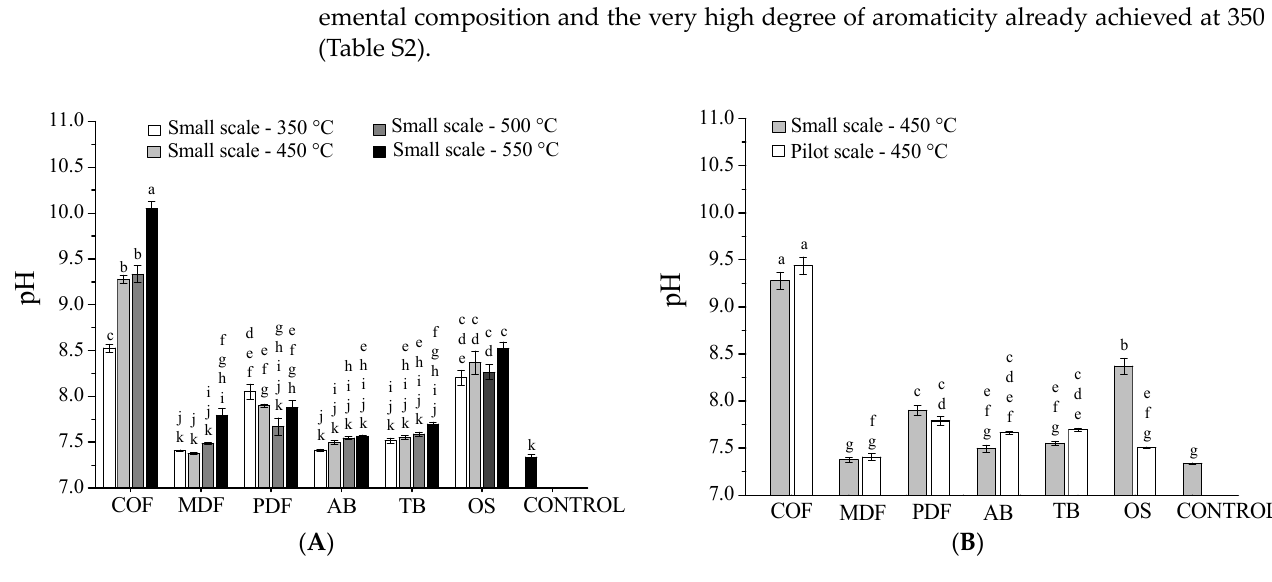
Figure 2. Influence of pyrolysis temperature ( A ) and upscaling ( B ) on the pH of biochar submerged in “Organization for Economic Cooperation and Development” (OECD) standard water. Means with different letters indicate statistically significant difference (Tukey’s HSD, p < 0.05). COF = coffee husks, MDF = medium-density fiberboard, PDF = palm date fronds, AB = AB wood waste, TB = tree bark, OS = olive stones, and control = OECD standard water. The lowercase letters above the columns are presented to compare different columns to each other. Columns with the same letter are not statistically different from each other, while columns with differing letters are statistically different from each other.